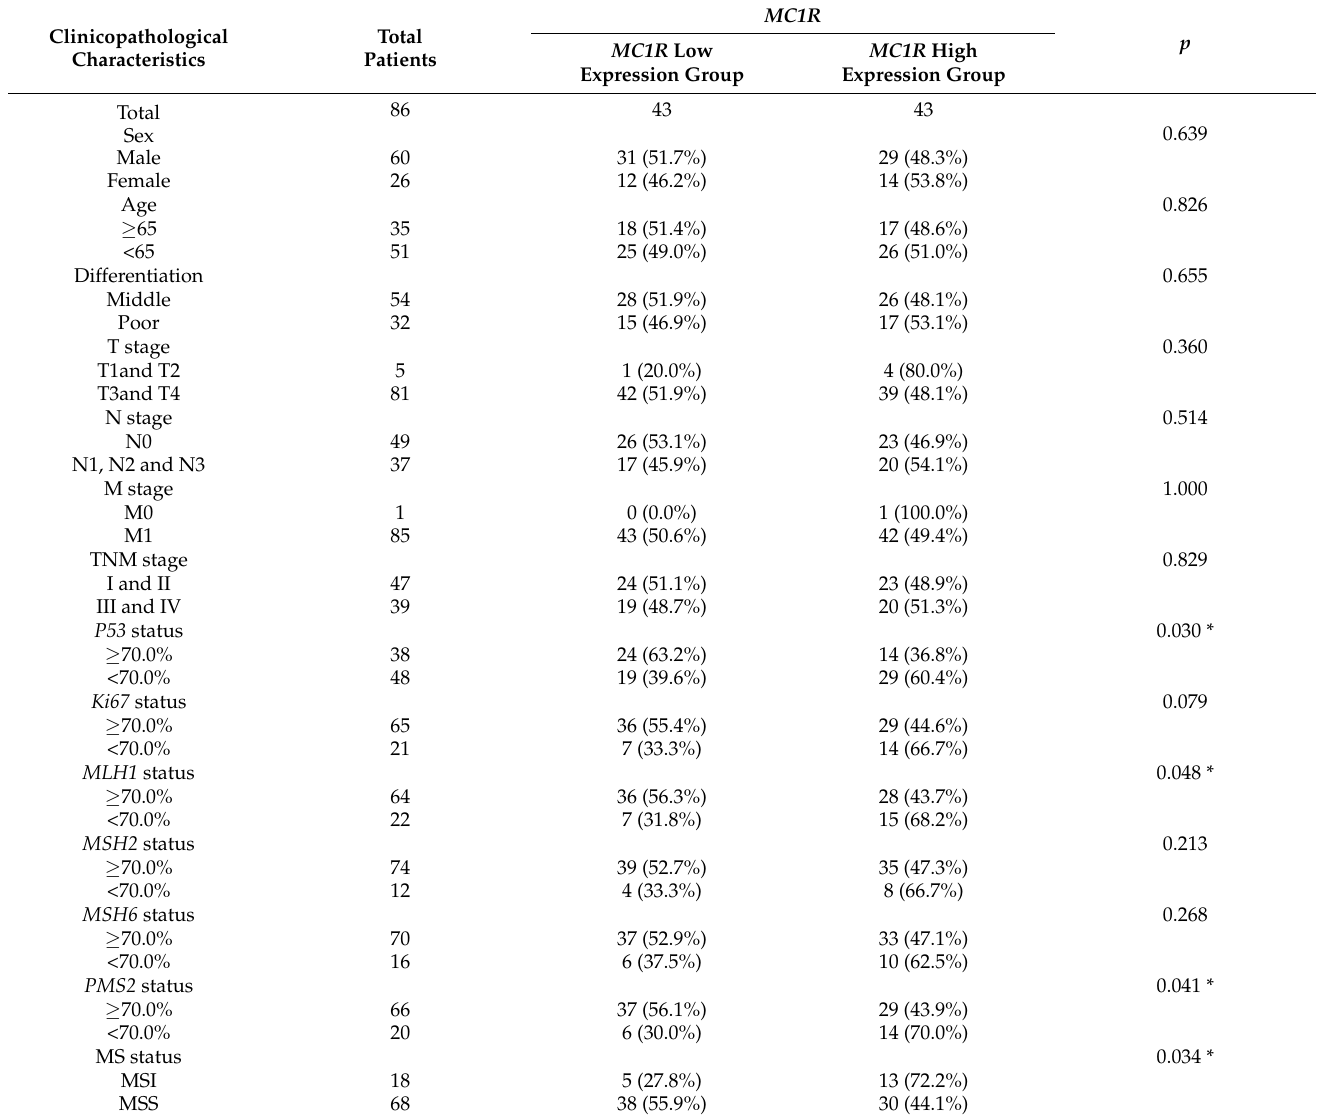
Table 1. Relationship between MC1R expression and clinicopathological characteristics of CRC patients. Clinicopathological